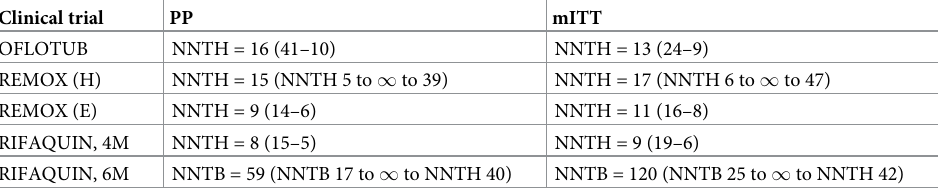
Table 2. NNTs with Cook and Sacket’s 95% CIs based on 18 month unfavourable outcome with fluoroquinolone- substituted regimens versus standard TB regimen in the PP and mITT populations. Clinical